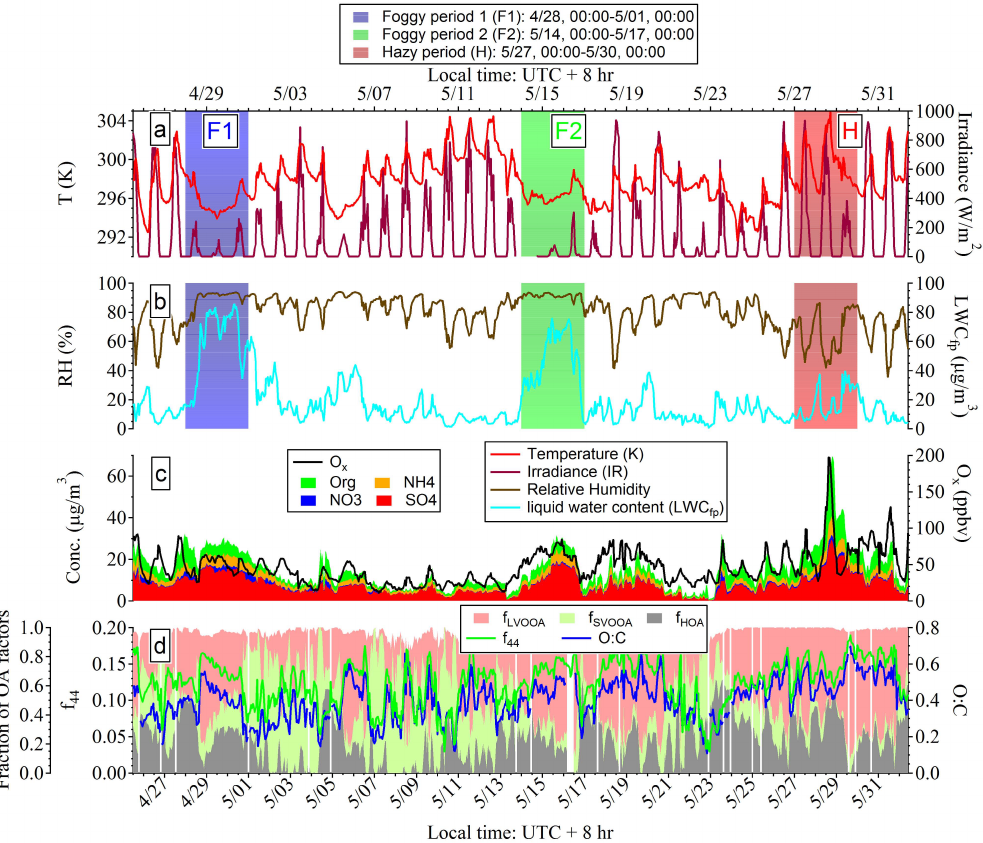
Fig. 1. (a, b) Meteorological conditions (temperature, irradiance, RH) and estimated fine-particle liquid water content (LWC fp ) , (c) NR-PM 1 species (sulfate, nitrate, ammonium, and organics) and odd oxygen (O x = O 3 + NO 2 ) concentrations, and (d) fractions of PMF-resolved OA factors (HOA, SVOOA, and LVOOA) and f 44 and O:C ratios of organics. Three periods – foggy period #1 (F1), foggy period #2 (F2), and hazy period (H) – were chosen for further